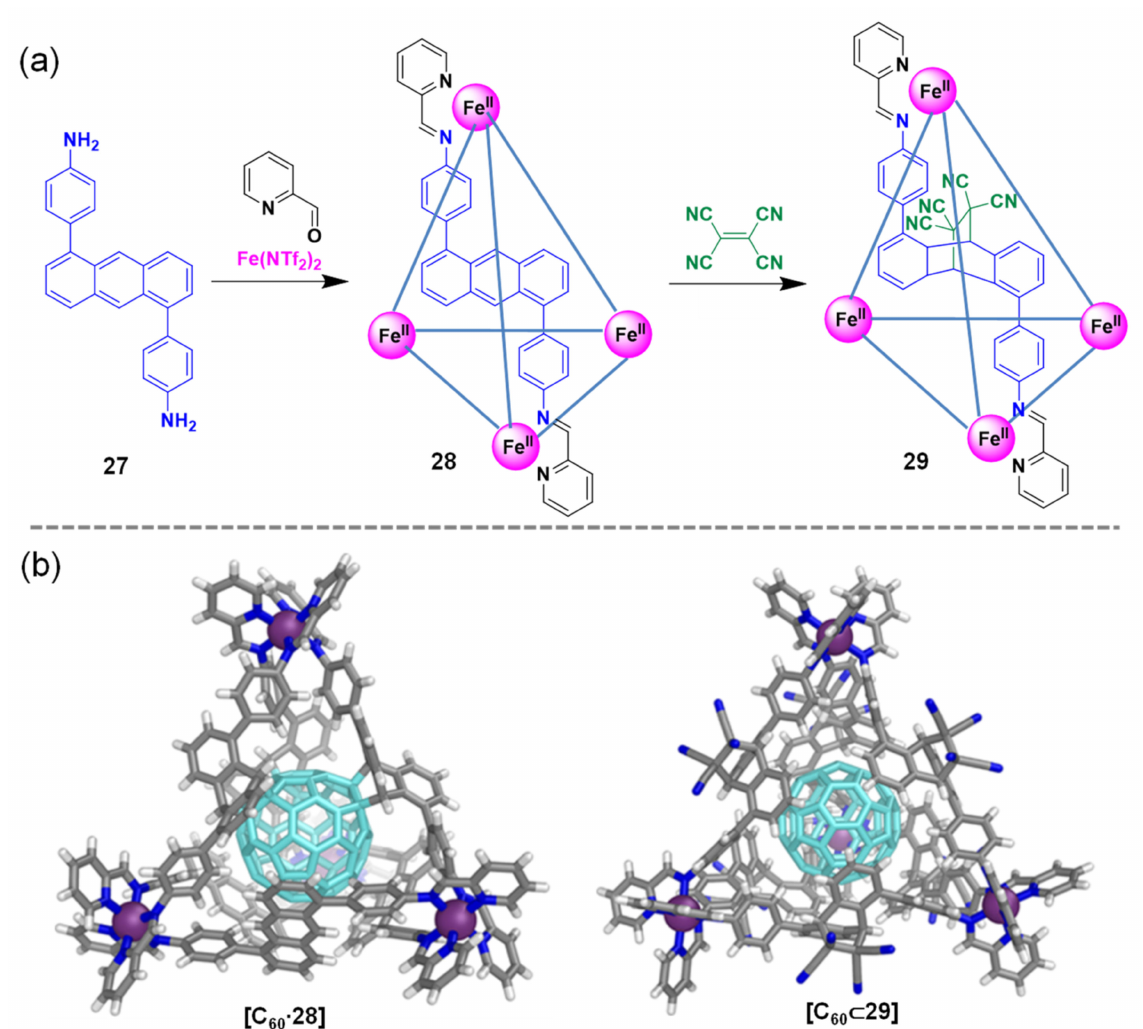
Figure 6. Anthracene-edged iron cages. ( a ) Formation of cage 28 and its post-modification with tetracyanoethylene to give 29 . ( b ) The crystal structures of the covalent adduct [C 60 · 28] and the host-guest complex [C 60 ⊂ 29] . Reprinted with permission from Ref. [24]. Copyright 2016 American Chemical